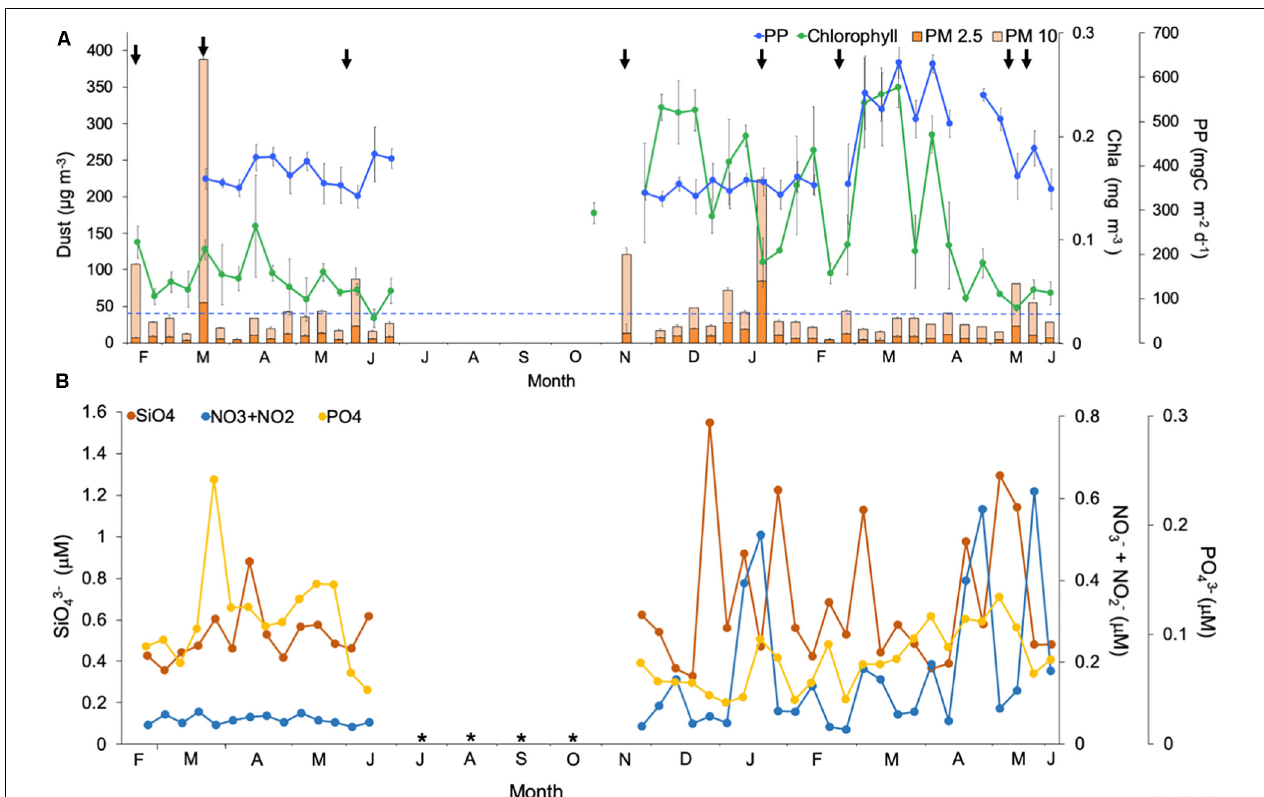
FIGURE 3 | Temporal variability of (A) average dust concentration of atmospheric Particulated Matter (PM, µ g m − 3 ) from three dust stations for particle size of 10 µ m ( (cid:4) ) and 2.5 µ m ( (cid:4) ), mean annual dust concentration at the North of Gran Canaria (– – –), statistically significant (Kruskal-Wallis One-way ANOVA, p < 0.05) dust events ( downarrow ), Chlorophyll a concentration (mg m − 3 , • ) in the mixed layer and Primary Production from satellite (mgC m − 2 d − 1 , • ); (B) average concentration ( µ M) of NO 3 + NO 2 ( • ), SiO 43 − ( • ) and PO 43 − ( • ) in the mixed layer for stations 2, 3, and 4. * No data